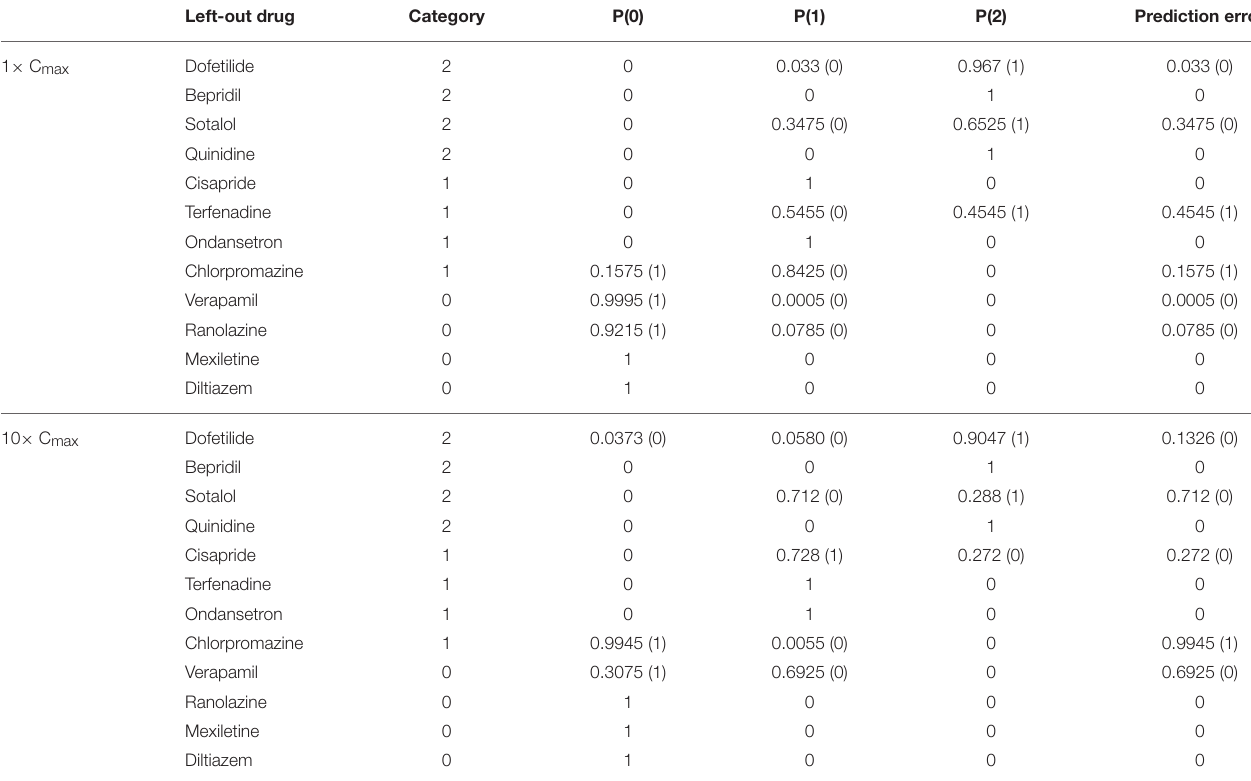
The TdP risk levels were assigned category values of 2 (High), 1 (Intermediate), and 0 (Low). A classifier was trained on 11 of 12 drugs and then used to predict the category probabilities [P(x), where x is the category value] and to obtain an overall prediction error for the remaining drug (see section Cross Validation). Uncertainty model simulations were used for training and prediction. For comparison, probabilities, and prediction errors from Dutta et al. (2017) are shown in parentheses when they differed from uncertainty results.